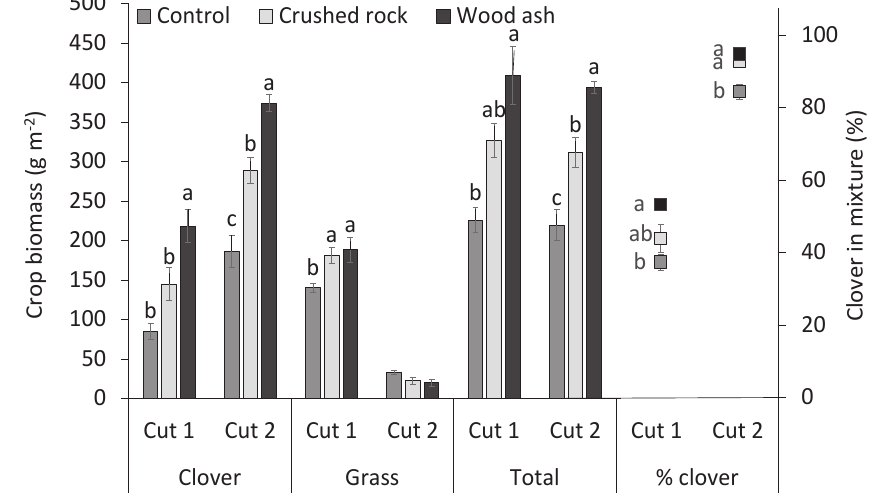
Fig. 1. Red clover, perennial ryegrass and total biomass (primary y axis), and percentage of clover in the mixture (secondary y axis). Data are given as Least-Squares Means, error bars indicate SEM, and different letters (a- c) indicate significant differences between treatments for crop species, crop mixture or clover percentage at each cut ( p ≤0.05;